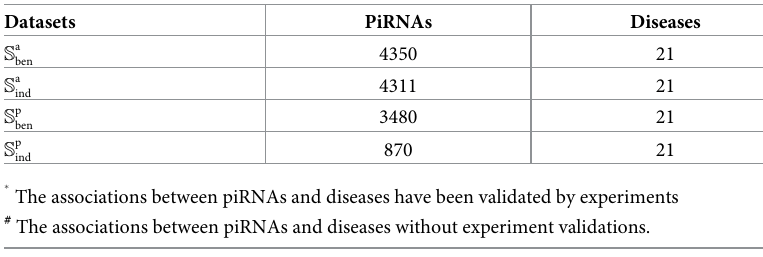
, S a , S p and S p . ben ind ben ind